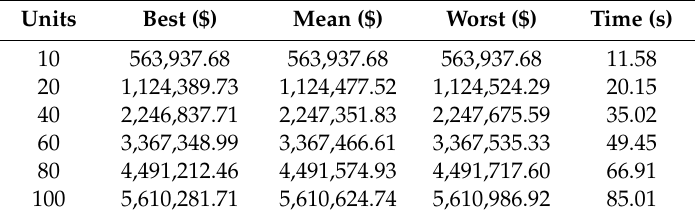
Table 3. Statistic experimental result of BCSO for di ff erent Unit numbers.